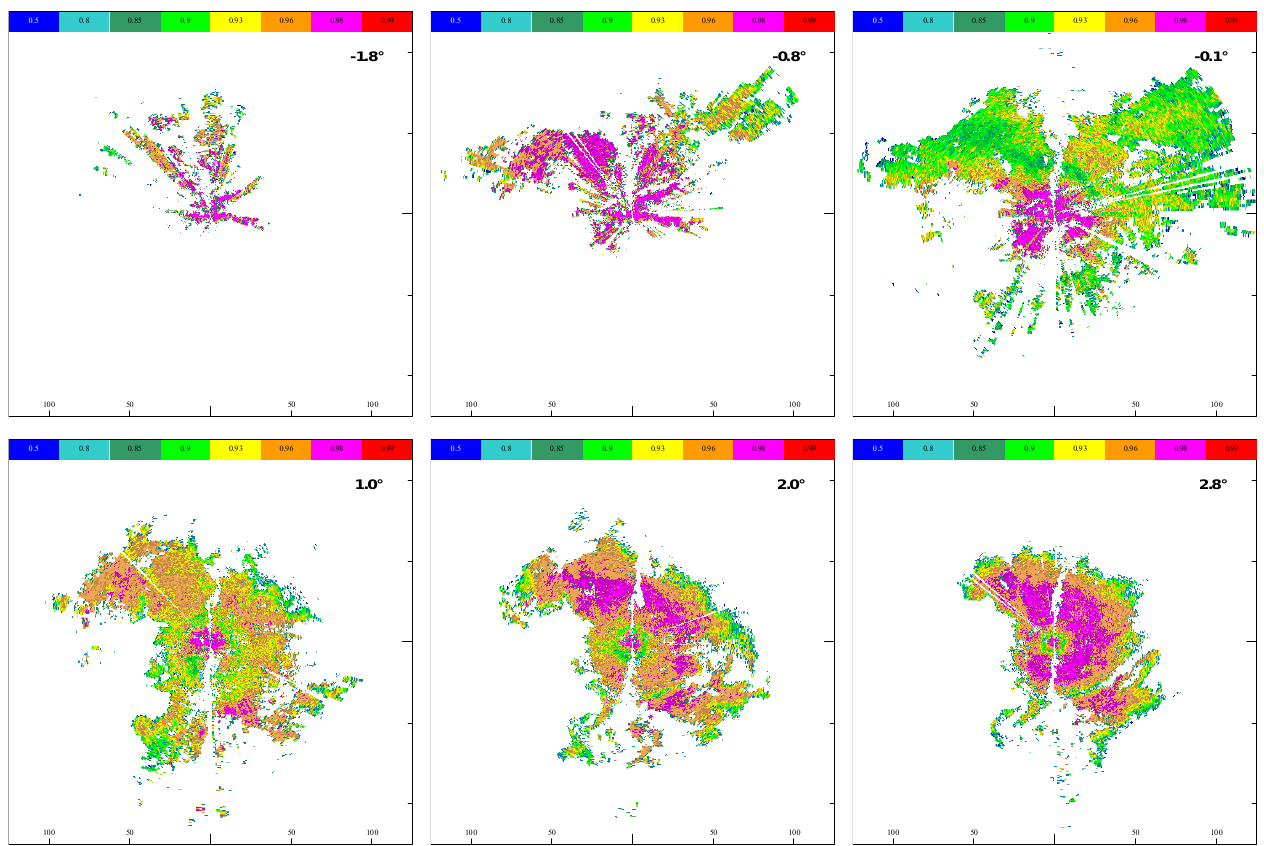
Fig. 4: PPI scans of ρ HV at various elevation angles from –1.8° to 2.8° (August 28, 2007, 0837 UTC). Fig. 4. PPI scans of ρ HV at various elevation angles from − 1.8 ◦ to 2.8 ◦ (28 August 2007,